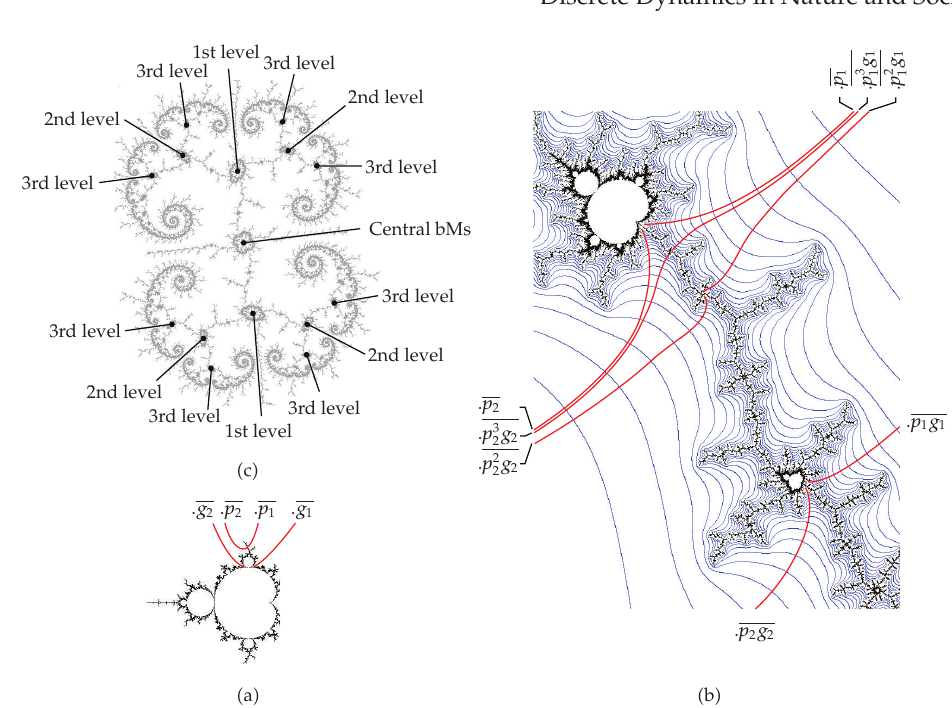
Figure 5: Canonical single-spiral medallions. (cid:4) a (cid:5) External rays of the parent and the gene. (cid:4) b (cid:5) Graphical location of the medallions i (cid:3) 1 , 2 and 3. (cid:4) c (cid:5) Detail of the medallion i (cid:3) 14 where the BMSs up to third level are pointed